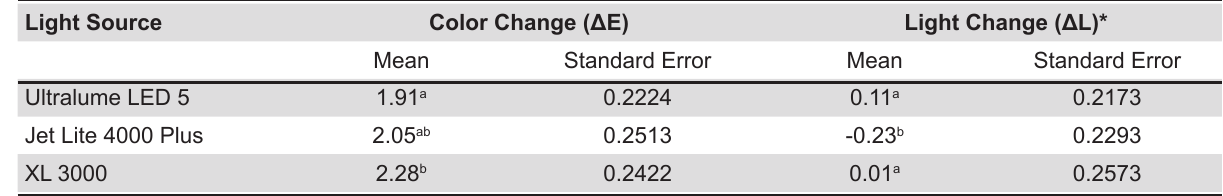
ΔE - gL=2; H=6.343928; p=0.041920 ΔL - gL=2; H=8.291655; p=0.015830 Similar letters indicate vertical statistical similarity (column). Table 2- Mean and standard error for color and light changes according to the immersion media